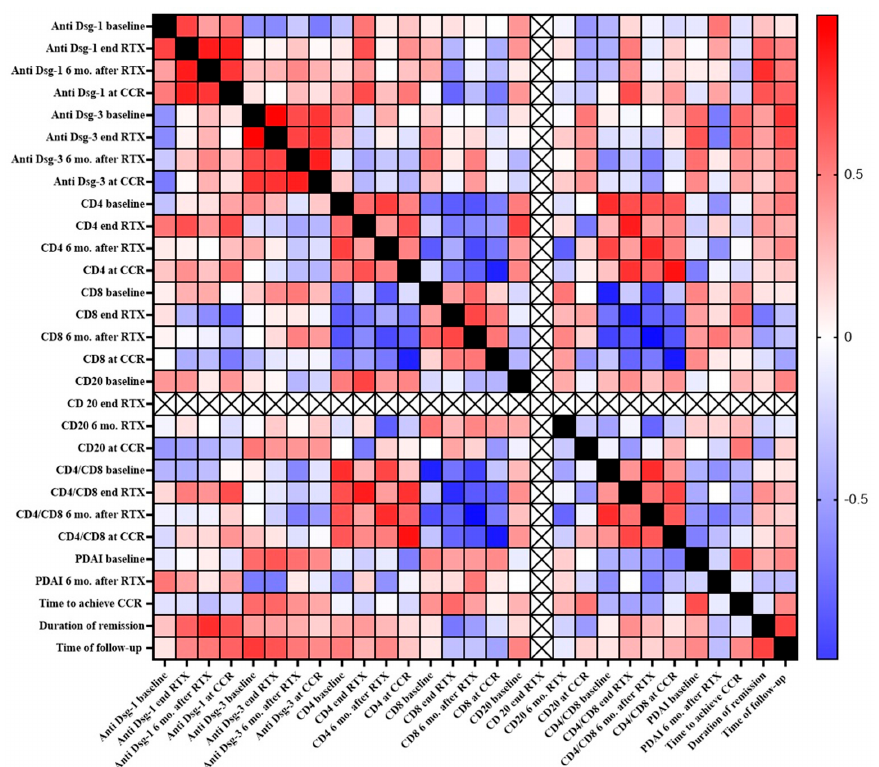
Figure 3. Heatmap of correlations among all the examined clinical and immunological variables. The following correla- tions were found significant: anti-Dsg-1 baseline vs. anti-Dsg-1 end RTX (p =0.027, r = 0.715); anti-Dsg-1 end RTX vs. anti- Dsg-1 6 mo. after RTX ( p = 0.005, r = 0.860); anti-Dsg-1 end RTX vs. anti-Dsg-1 at CCR ( p = 0.004, r = 0.845); anti-Dsg-1 end RTX vs. CD4 end RTX ( p = 0.038; r= 0.675); anti-Dsg-1 6 mo. after RTX vs. anti-Dsg-1 at CCR ( p = 0.015; r = 0.767); anti-Dsg- 1 6 mo. after RTX vs. duration of remission ( p = 0.009, r = 0.798); anti-Dsg-1 at CCR vs. CD4 end RTX ( p = 0.032, r = 0.688); anti-Dsg-1 at CCR vs. CD4/CD8 end RTX ( p = 0.035; r = 0.682); anti-Dsg-1 at CCR vs. duration of remission ( p = 0.042, r =